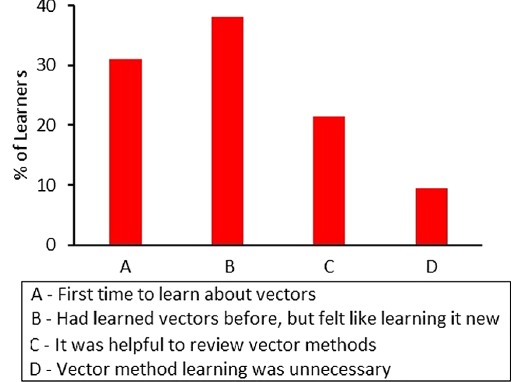
FIG. 4. Learners ’ opinionsaboutlearningbasic vectormethods in the CBphysicscourse. The heightoftheverticalbars are the percent learners who fell into each category listed along the horizontal axis. 31% of learners claimed it was their first time to learn about vectors, while 38% claimed that although they were not new to vectors, they felt as if they acquired the knowledge of vectors for the first time. preparation overall to learning physics in college.